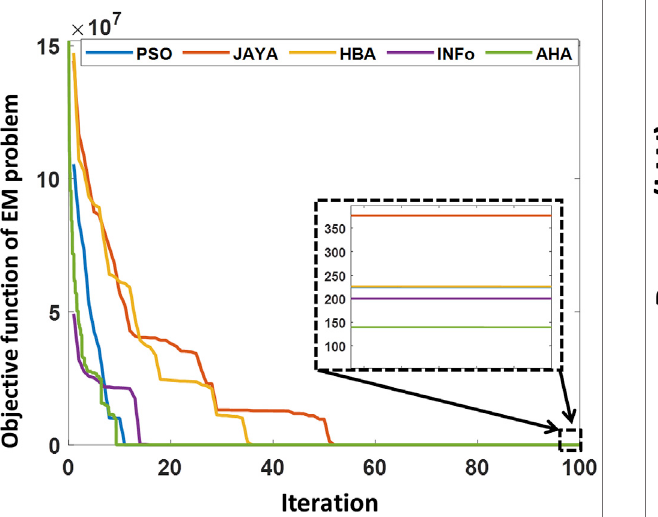
FIGURE 5 | Optimal output power for conventional generation units obtained by AHA (case 1).